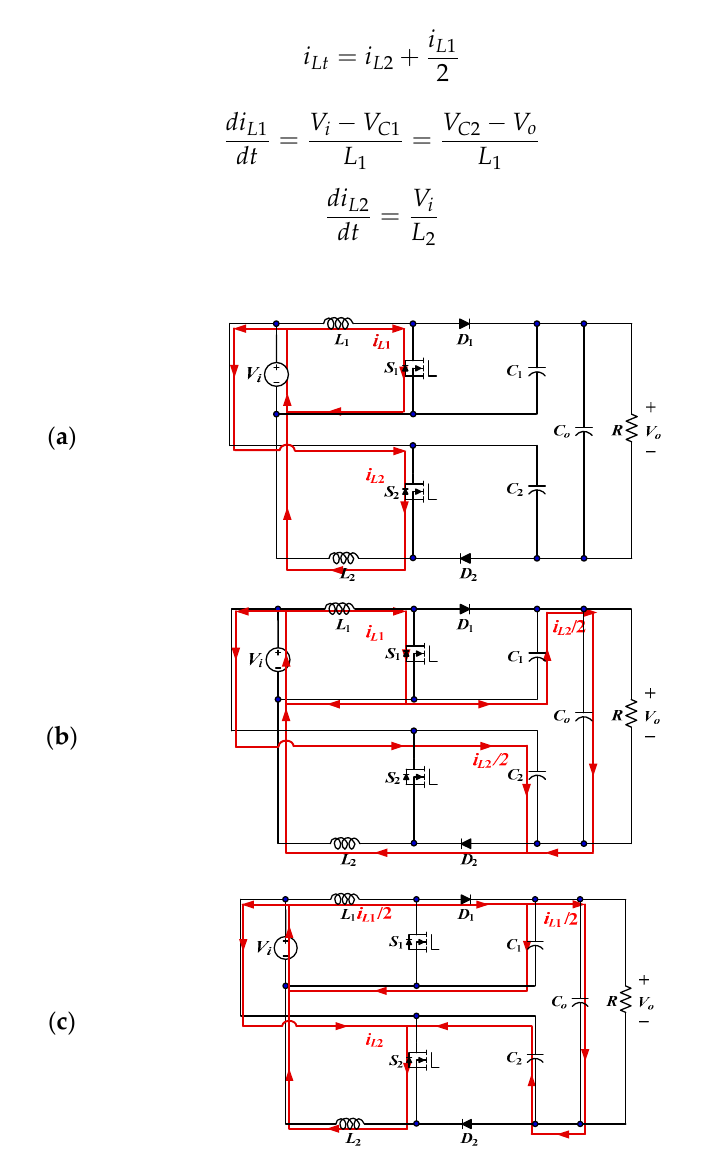
Figure 3. Working modes and equivalent circuits of the combined boost converter. ( a ) Mode 1 and Mode 3, ( b ) Mode 2, and ( c ) Mode 4.